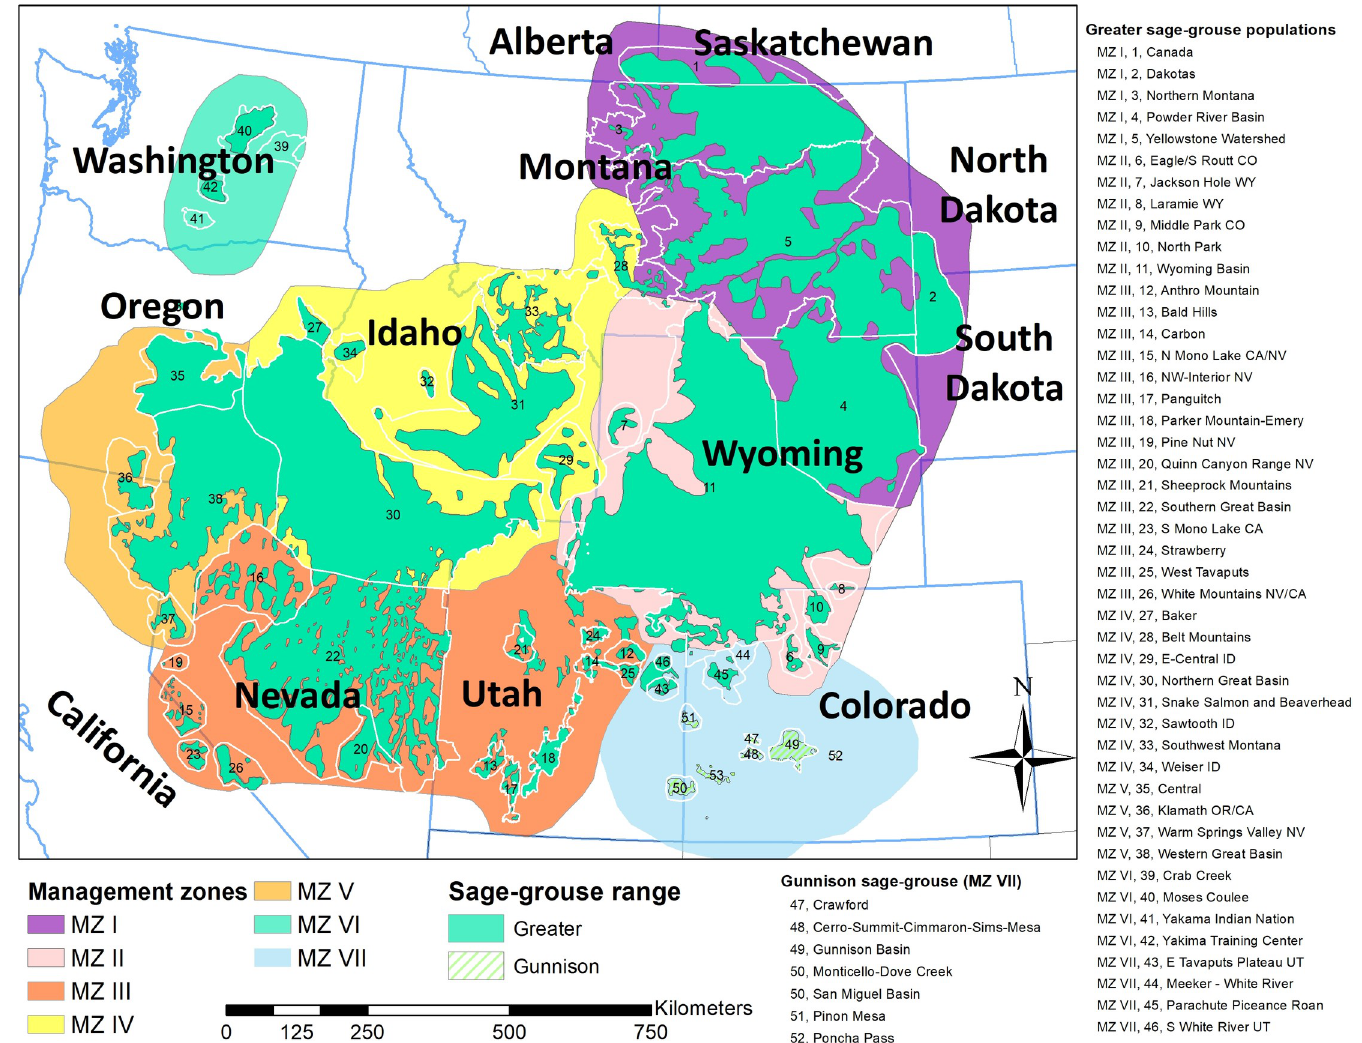
Fig 1. Assessment region, encompassing eleven states and two provinces stratified as seven management zones, and the extant range of both the greater and Gunnison sage-grouse. Population names were defined in USFWS listing documents [4, 5].